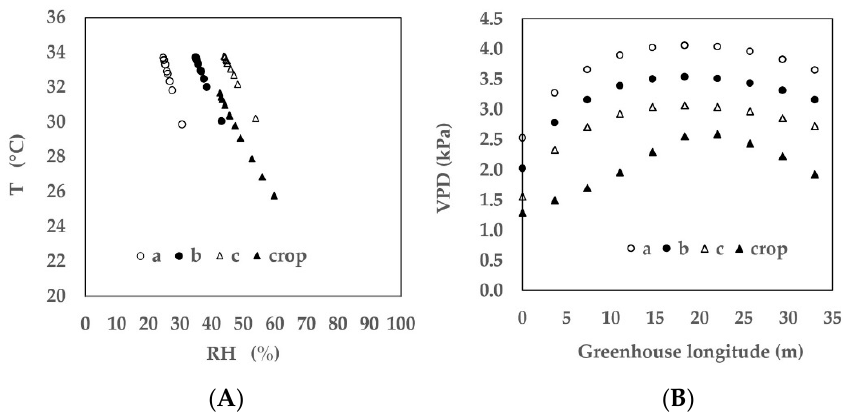
Figure 3. ( A ) Temperature distribution (°C) and ( B ) VPD (kPa) for the simulated scenarios along the length of greenhouse at 1.5 m height. The three scenarios a, b and c, and simulating the incorporation of a tomato crop to develop LAI 3.5.